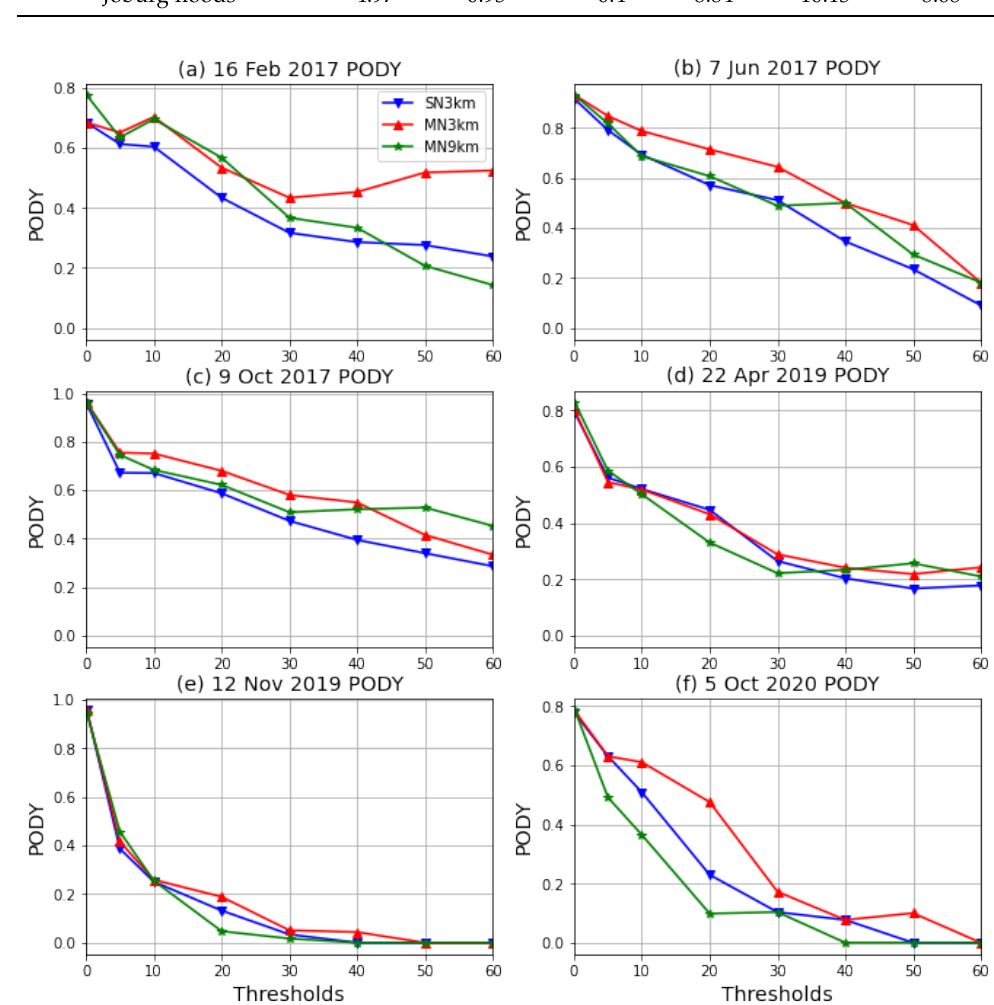
Figure 10. The probability of detecting yes score for the three configurations and for all six events in the following order: ( a ) tropical cyclone Dineo, ( b ) the Cape storm, ( c ) the KZN 2017 October floods, ( d ) the KZN 2019 April floods, ( e ) the KZN 2019 tornadoes and ( f ) the Johannesburg floods. Unlike with PODY, a perfect FAR score is 0, which implies that the model should